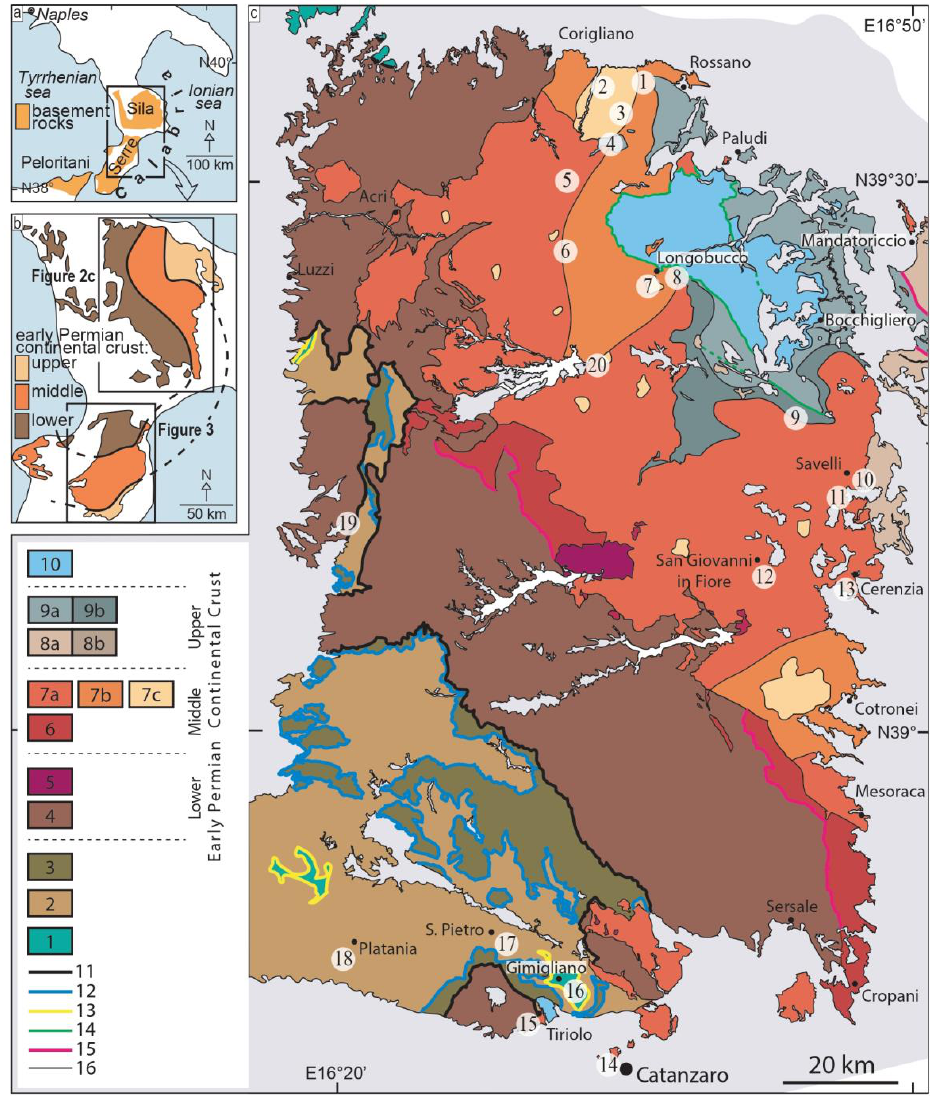
Figure 2. ( a ) Sketch map showing the distribution of basement rocks exposed in Southern Italy (modified after [71]); ( b ) sketch map of the lower, middle, and upper late-Variscan continental